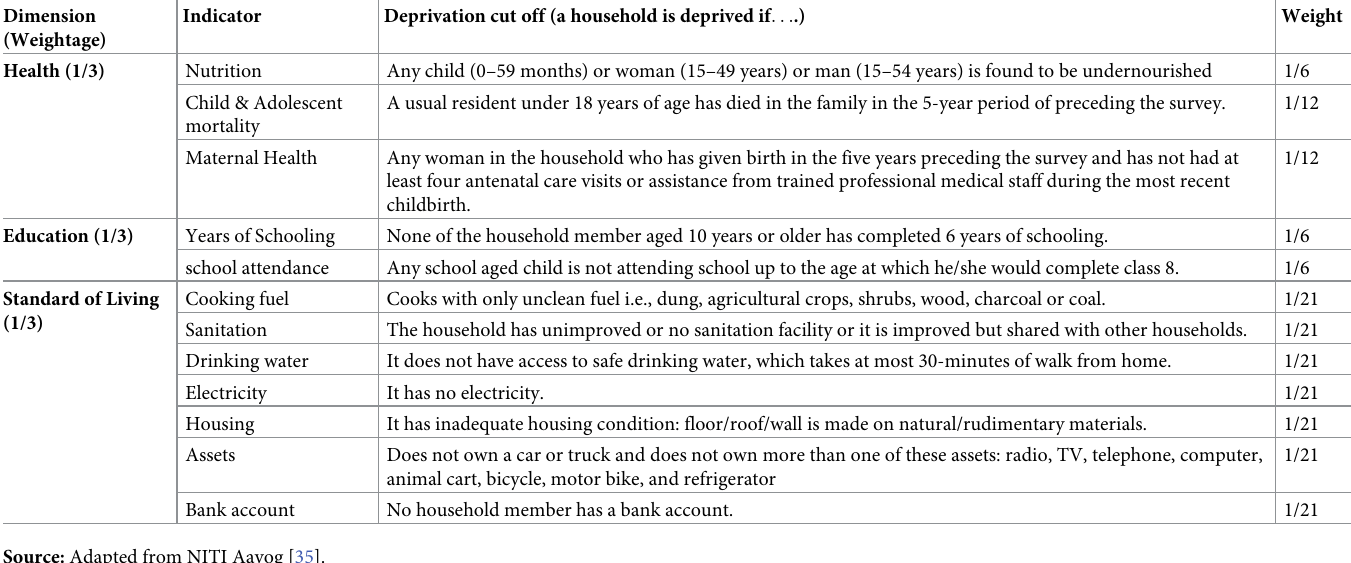
Table 1. Dimensions, indicators, deprivation cut-offs, and indicators’